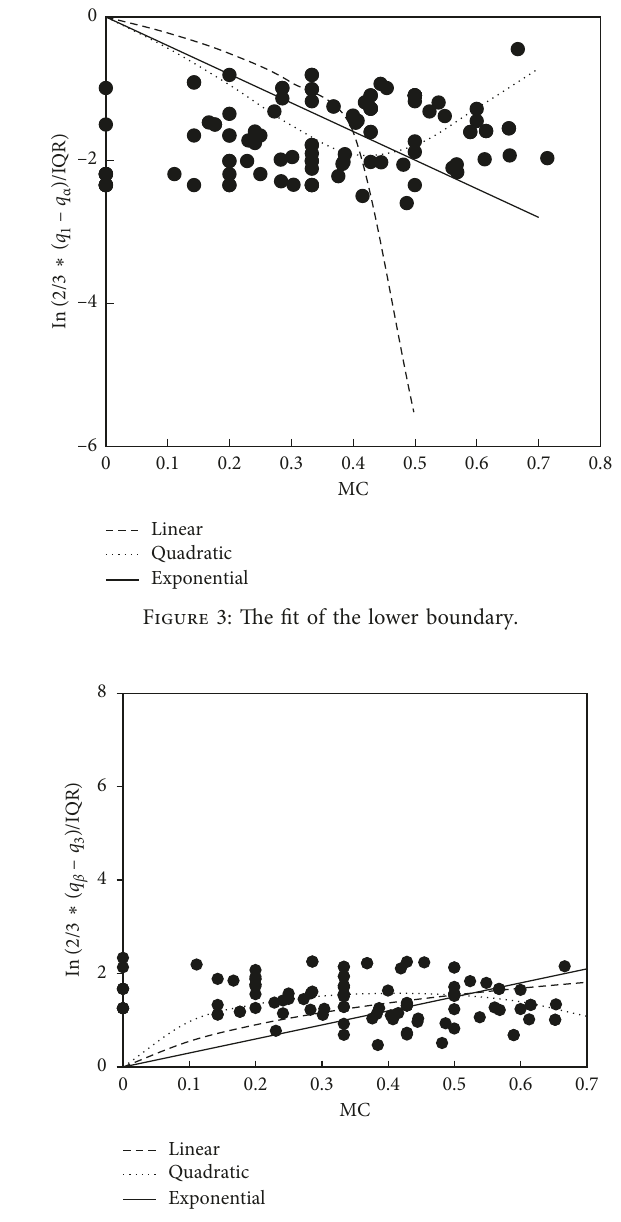
Figure 4: The fit of the upper